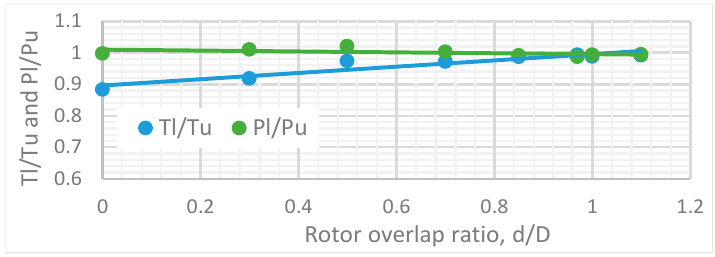
Figure 19. Thrust and power ratios of the upper and lower rotors ( z / D = 0.05) (overall thrust, 8 N).